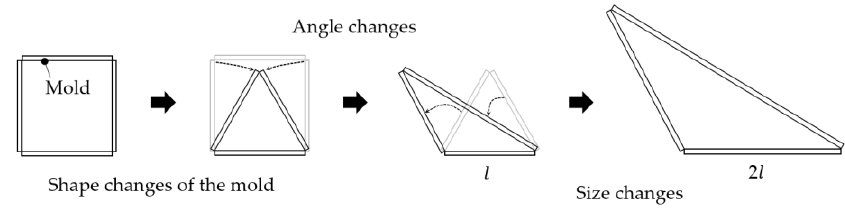
Figure 3. Requirement of the mold.